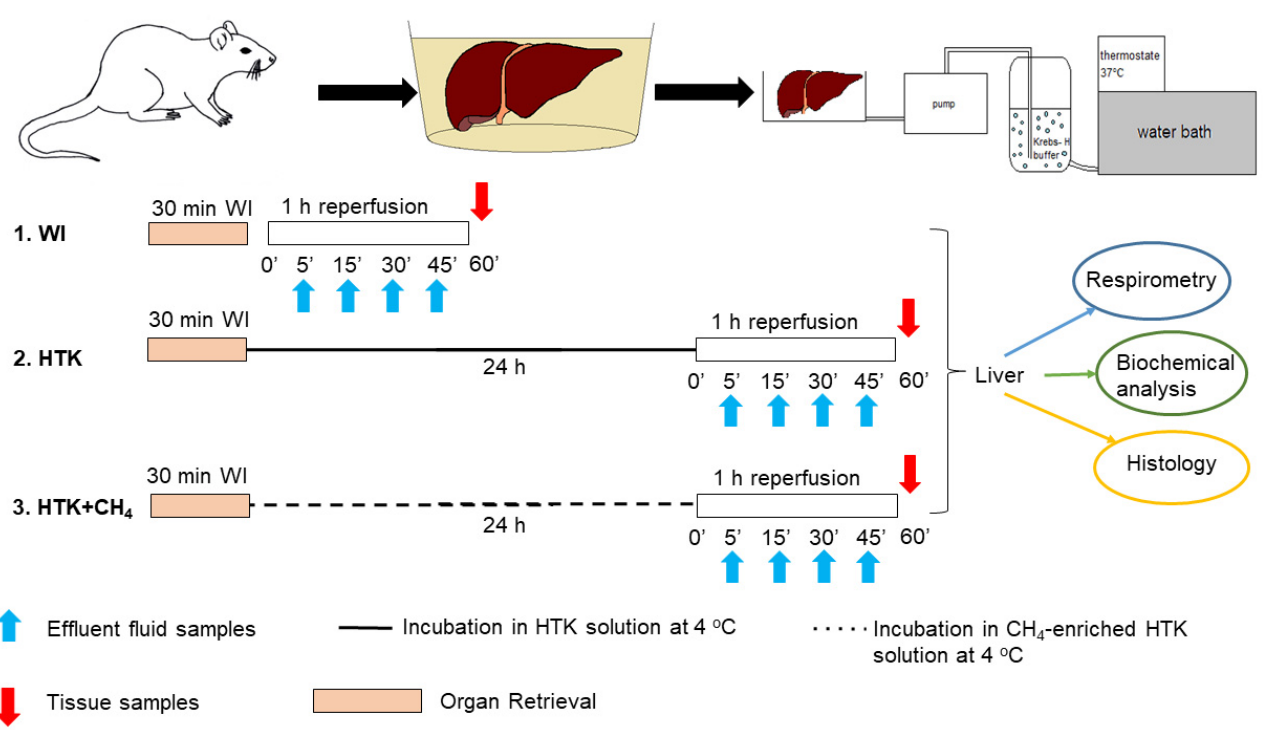
Figure 1. Study protocol. Preparation and perfusion of donor livers. Grafts in the WI group were subjected to immediate perfusion following retrieval. The other groups were incubated in HTK and CH 4 -enriched HTK solution (HTK + CH 4 ), respectively, at 4 °C for 24 h prior to organ perfusion. Perfusate samples were obtained during reperfusion for biochemical analysis (indicated with blue arrows). At the end, tissue samples were taken for further analysis (indicated with red arrows). WI: warm ischemia; HTK: histidine–tryptophan–ketoglutarate; CH 4 : methane; HTK + CH 4 : CH 4 -en- riched HTK.